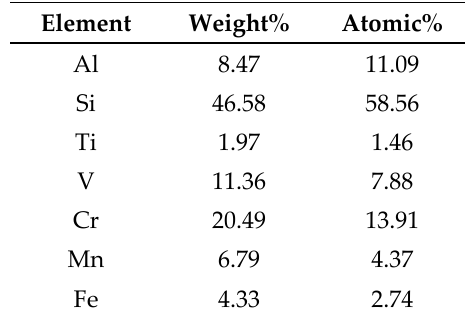
Figure 7. EDS diagram and chemical composition at point no. 2 of Figure 5.